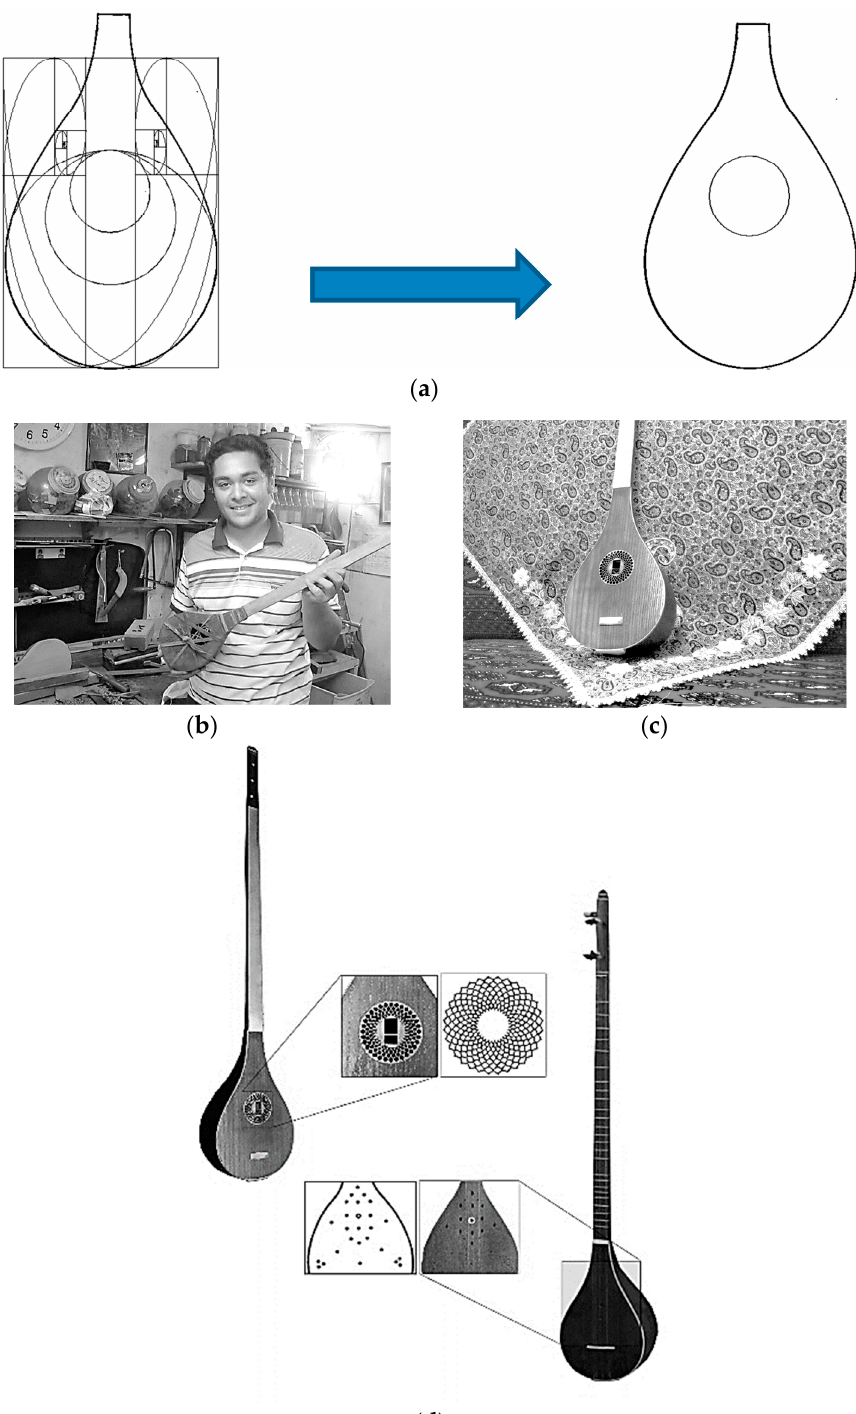
Figure 11. New optimized musical instrument ‐ manufacturing procedure. ( a ) Raw application of the Golden Method; ( b ) Manufacturing procedure based on the Golden Method; ( c ) Final musical instrument, the Mahava; ( d ) Comparison between the Mahava and Delroba.